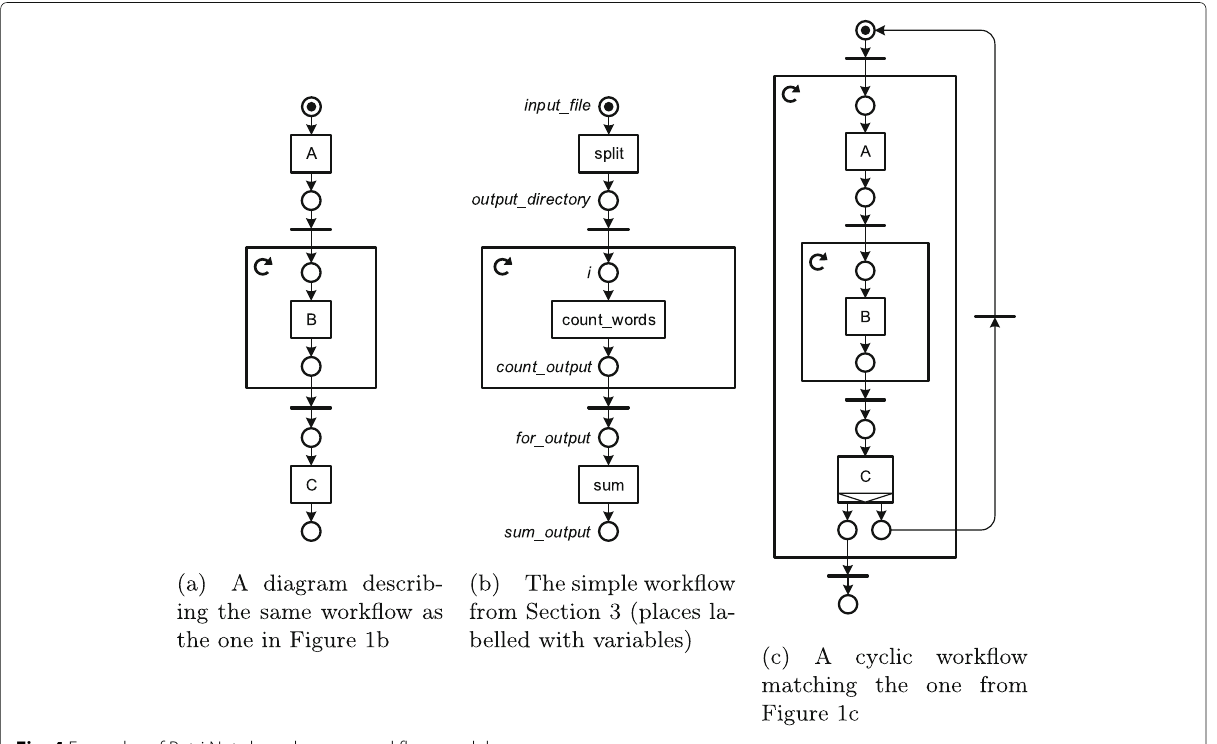
Fig. 4 Examples of Petri Nets based on our workflow model